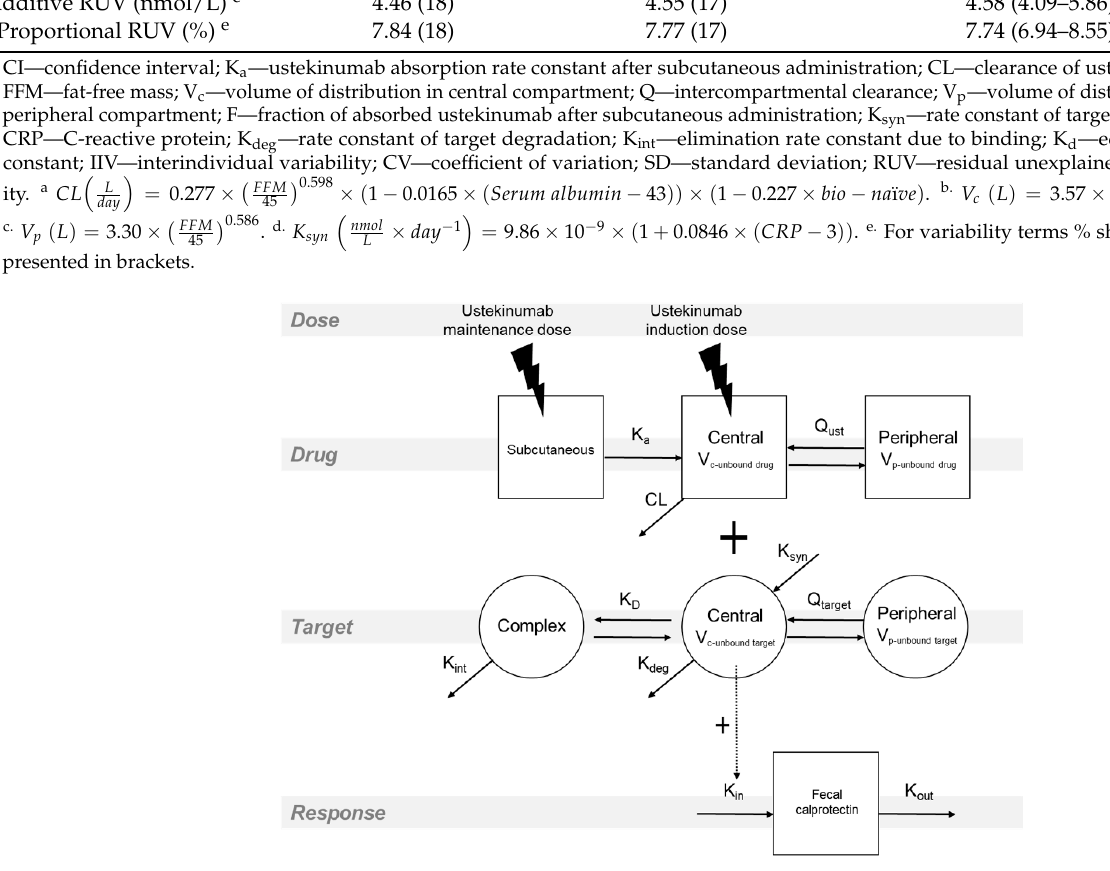
Figure 1. Schematic of the population pharmacokinetic–pharmacodynamic model. A first-order absorption of ustekinumab (drug) is assumed after the subcutaneous administration. The distribution of the unbound drug and unbound target is described with the two-compartment models. The binding is assumed in the central compartment and is described with the quasi-equilibrium approximation of the target-mediated drug disposition model. The stimulating effect of the unbound target on the fecal calprotectin is described with the indirect response model. Ka: ustekinumab absorption rate constant after the subcutaneous administration; V c : volume of distribution in the central compartment; V p : volume of distribution in the peripheral compartment; Q UST : intercompartmental clearance of unbound ustekinumab; CL: clearance of unbound ustekinumab; K syn : rate constant of target synthesis; K deg : rate constant of target degradation; K D : constant of the equilibrium between unbound drug, unbound target and drug-target complex; K int : rate constant of internalization of the drug-target complex into the cells; Q target : intercompartmental clearance of unbound target; K in : rate constant of calprotectin production; K out : rate constant of fecal calprotectin degradation. Table 2. Base and final pharmacokinetic model parameter estimates.